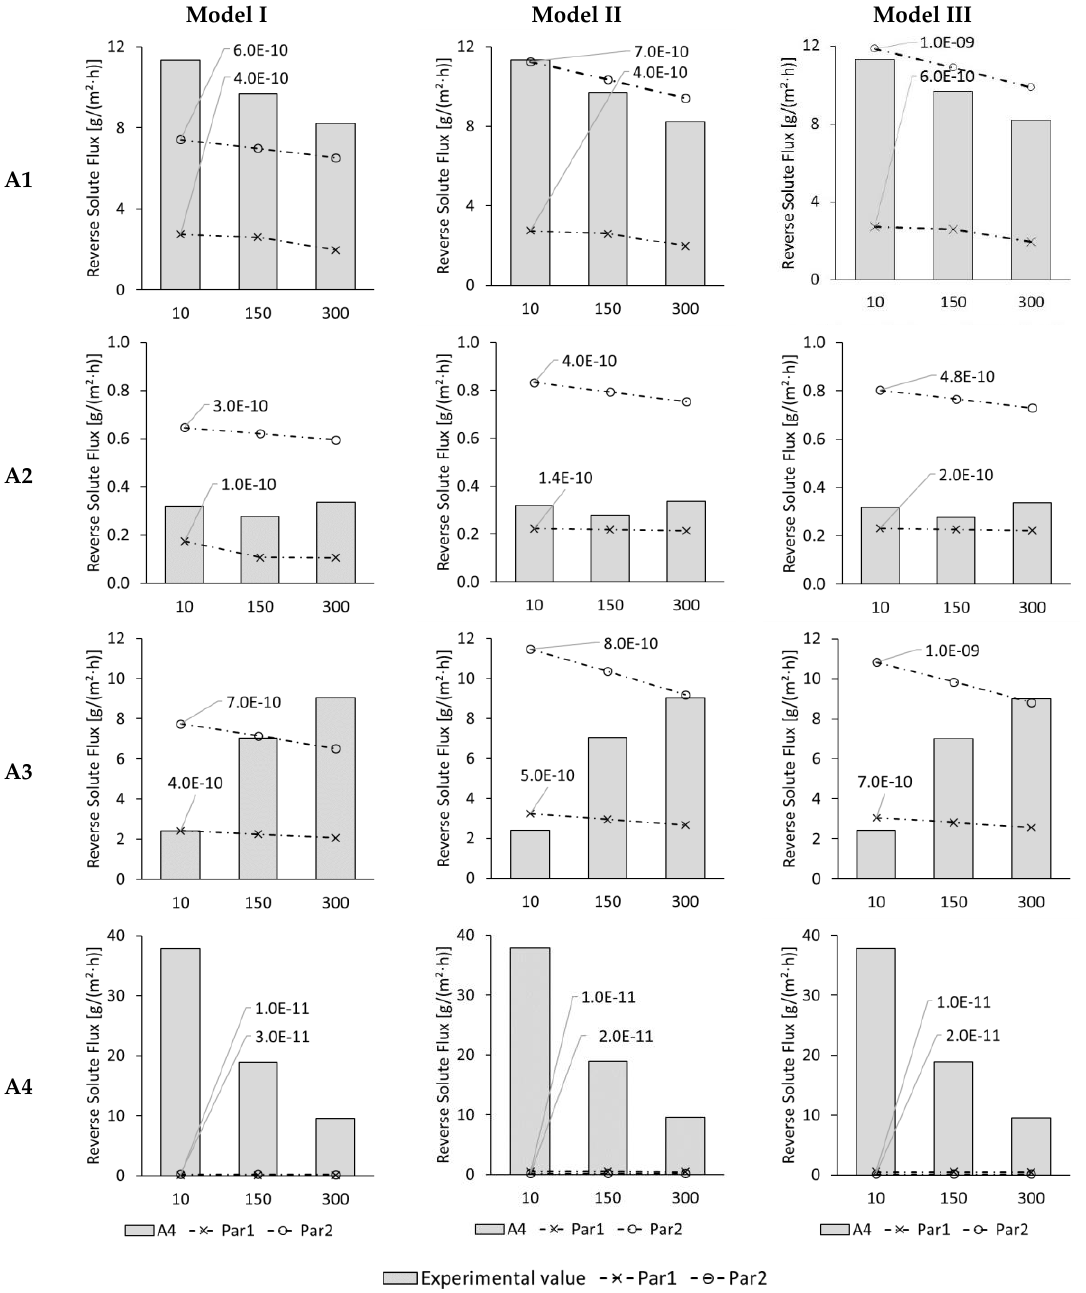
Figure 5. ALFS reverse solute fluxes of test series A1, A2, A3, and A4 for 10, 150, and 300 min test time from experiments (columns) and Model I, Model II, and Model III with membrane parameter set Par1 (dashed line with crosses) and Par2 (dashed line with circles). Modelled results are shown for best-fitting diffusion coefficient which is indicated next to the corresponding line.